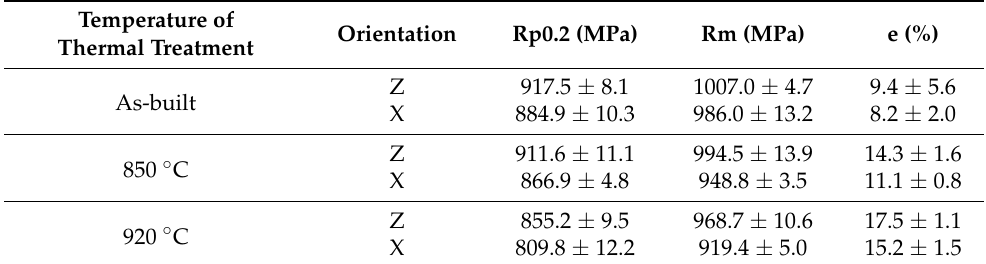
Table 4. Mechanical properties (Rp0.2: yield strength, Rm: ultimate tensile strength, e: elongation) achieved for both orientations for WAAM parts treated at different